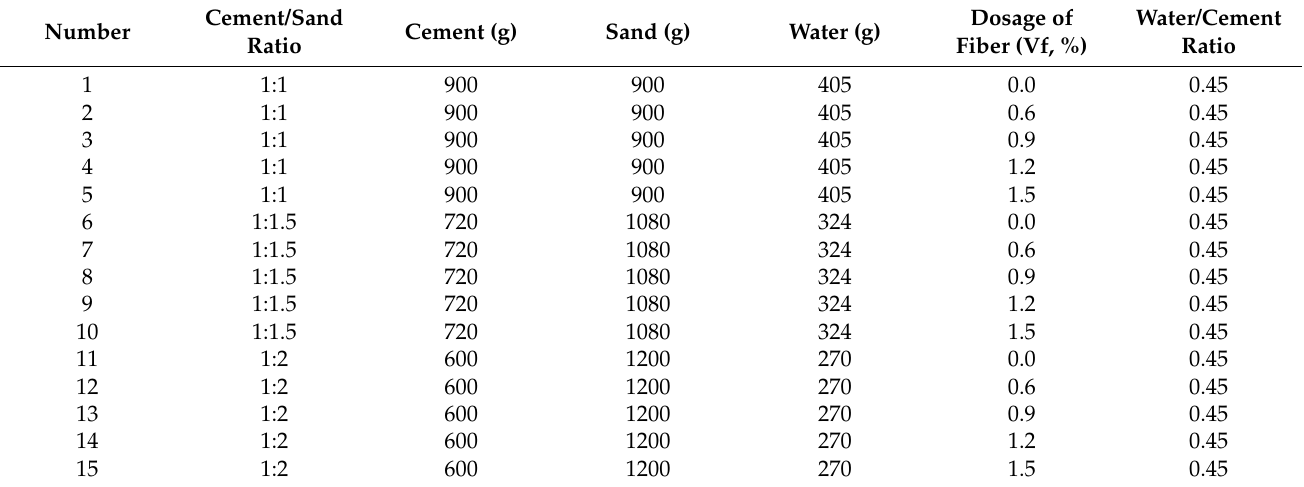
Table 4. Cement mortar mix ratio